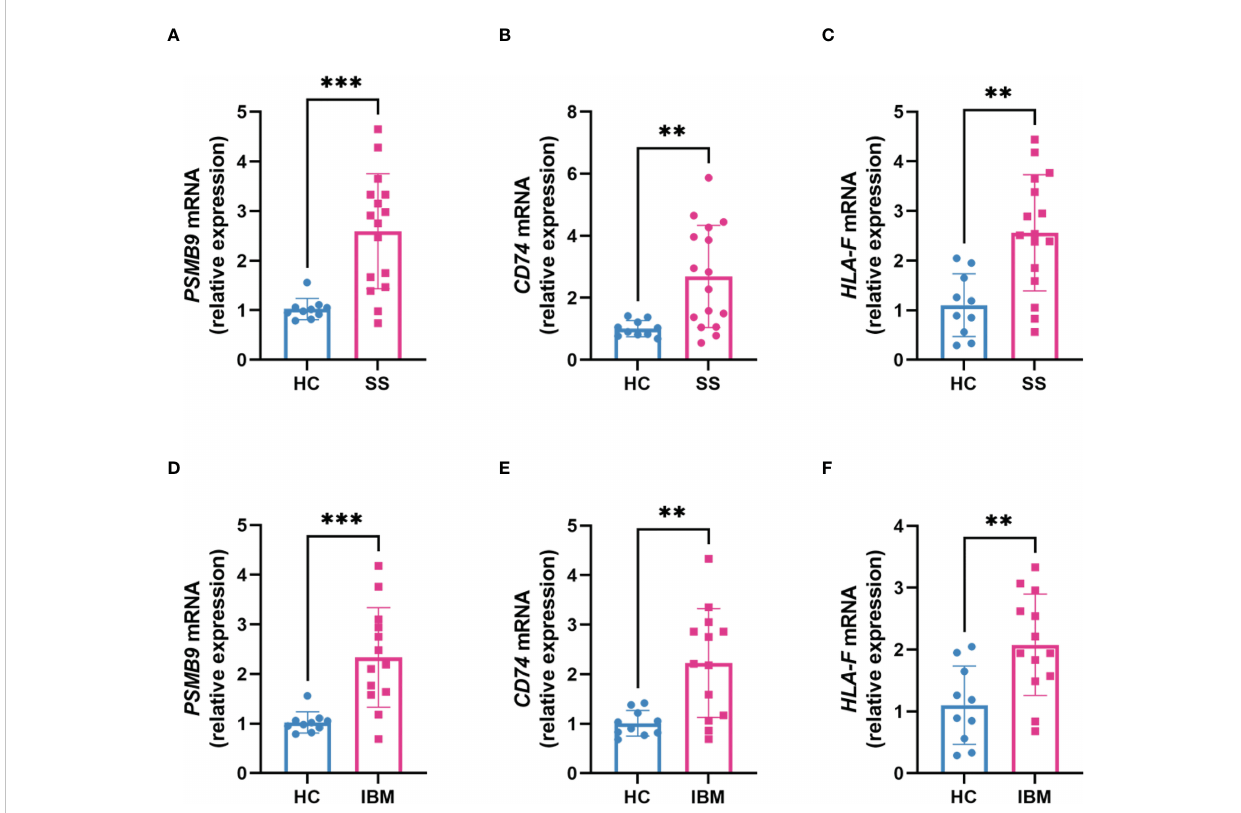
FIGURE 6 Transcription levels of hub genes in clinical SS and IBM patients. (A – C) The expression of PSMB9 , CD74 and HLA-F mRNA in SS patients (n=16) compared with healthy controls (n=10). (D – F) The expression of PSMB9 , CD74 and HLA-F mRNA in IBM patients (n=13) compared with healthy controls (n=10). The two groups were compared using a nonparametric Student ’ s t test with a P value of 0.05. *** p <0.001; ** p <0.01; SS, Sjögren syndrome; IBM, inclusion body